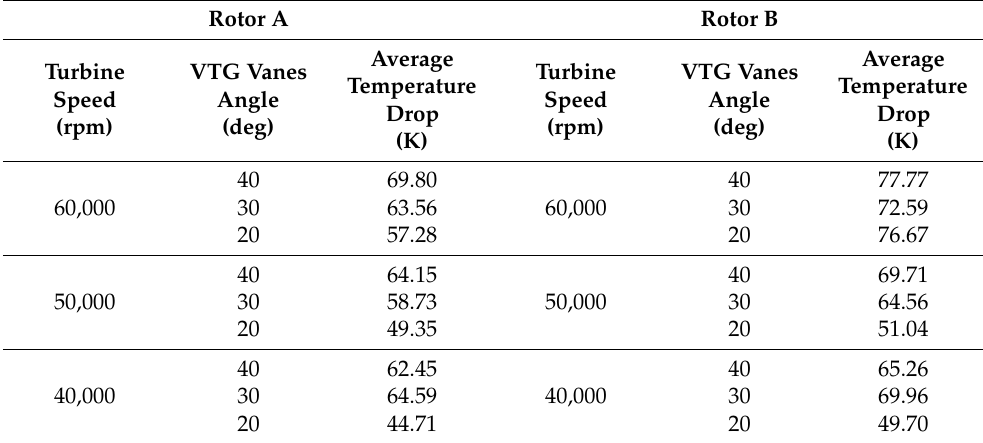
Table 9. The average temperature drop at the first-stage rotor for two different rotor geometries, three turbine speeds and VTG